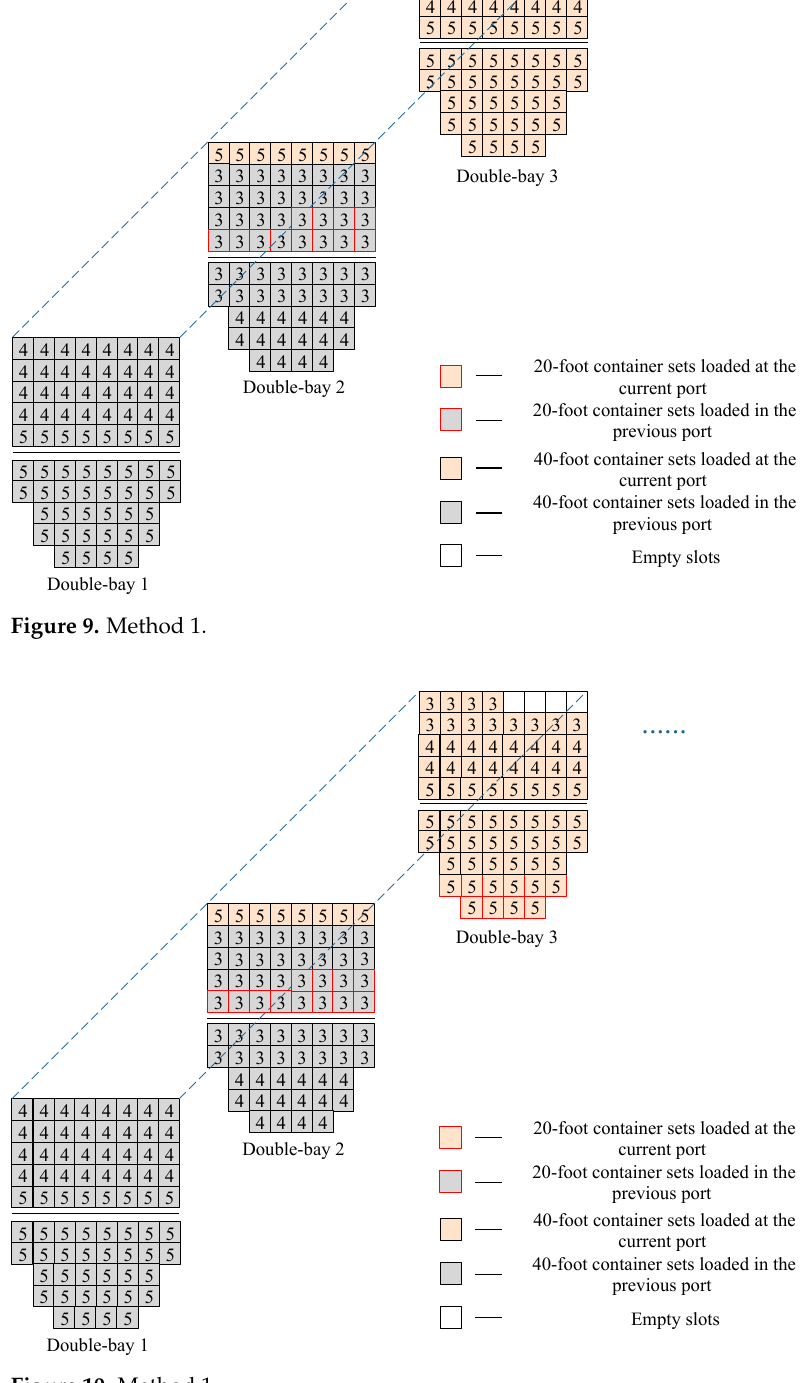
Figure 10. Method